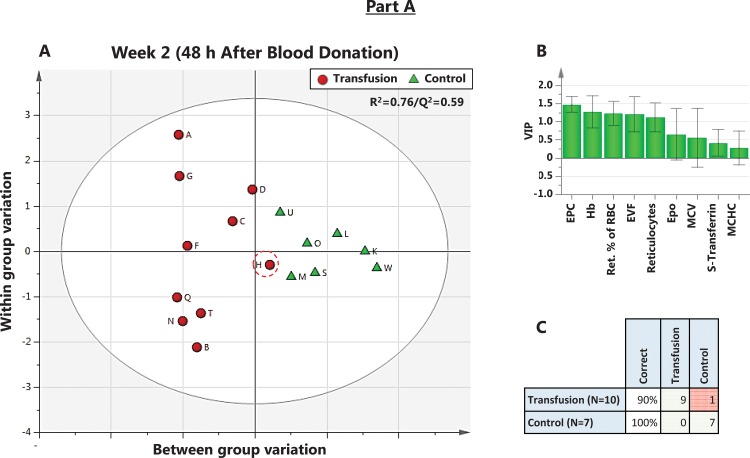
Part A of the Study.An OPLS-DA analysis at 48 h after blood donation. A) Scores Scatter plot showing separation of Control and Transfusion groups 48 h after blood donation. This plot shows how the modeled observations in X space are situated with respect to each other. Observations close to each other are more similar than observations distant from each other. Regression (R 2) = 0.76, and prediction by cross-validation (Q 2) = 0.59. B) VIP rank for included variables. C) Misclassification table showing one incorrectly predicted Transfused (Subject H, circled in red) to the Control group (p < 0.001, Fisher’s exact probability test).